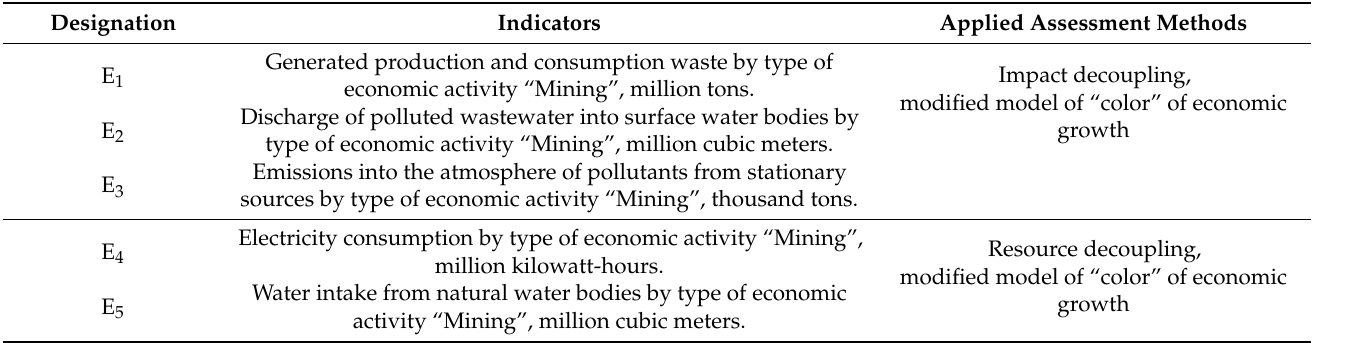
Table 1. Absolute indicators of the eco-intensity of the mining